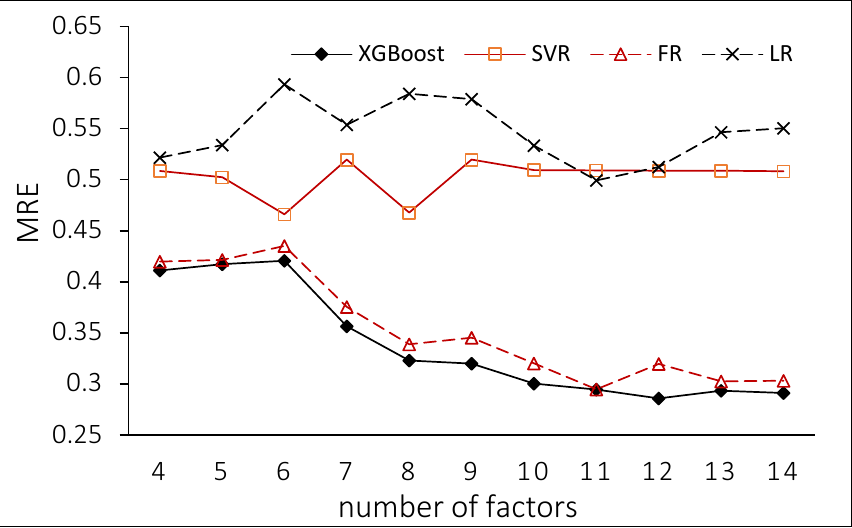
Figure 7. MRE based on different methods.